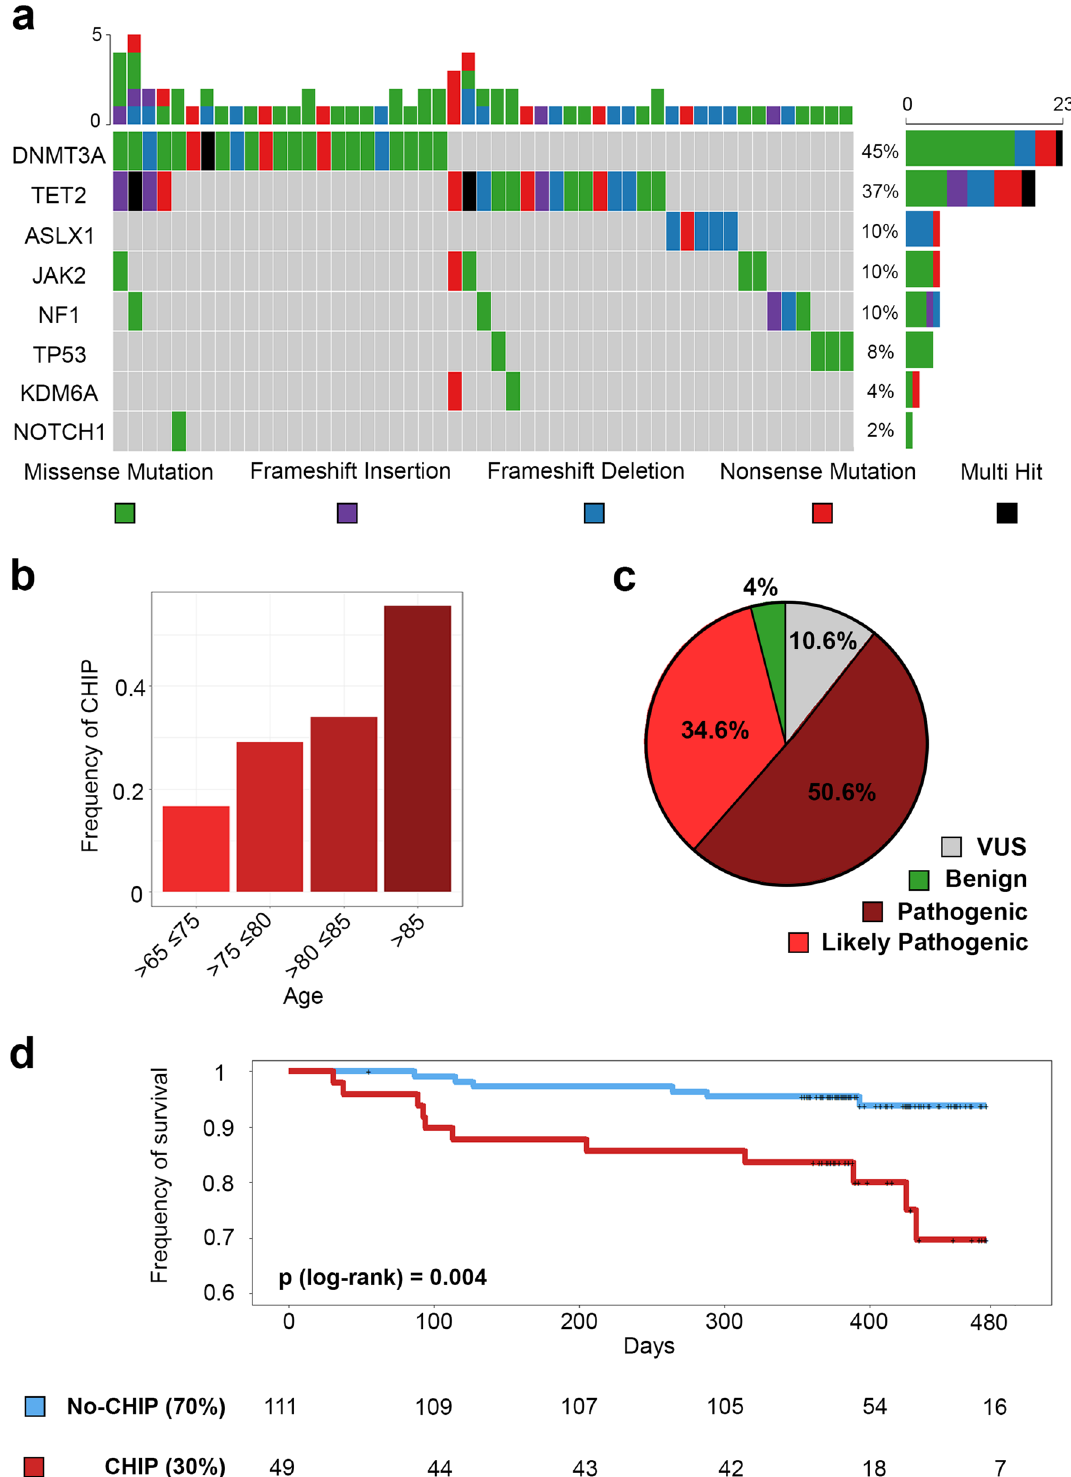
Figure 1. Identified mutations and survival. ( a ) Mutations landscape in the 9 genes. (Top panel) Each column represents per-sample mutations, with a range from a minimum of one to a maximum of 5, (Lower panel) Color-coded matrix of individual mutations, rows show the mutation distributions among the genes. On the right panel is shown the percentage of per-gene mutations. ( b ) Frequency of CHIP in our cohort divided by age ranges. The color gets darker as the frequency increases. ( c ) Pie chart of variants clinical annotation from VarSome. ( d ) Kaplan–Meier cumulative survival curves of CHIP (red) vs No-CHIP (blue). The number of CHIP and No-CHIP patients over the time in our cohort is shown below the